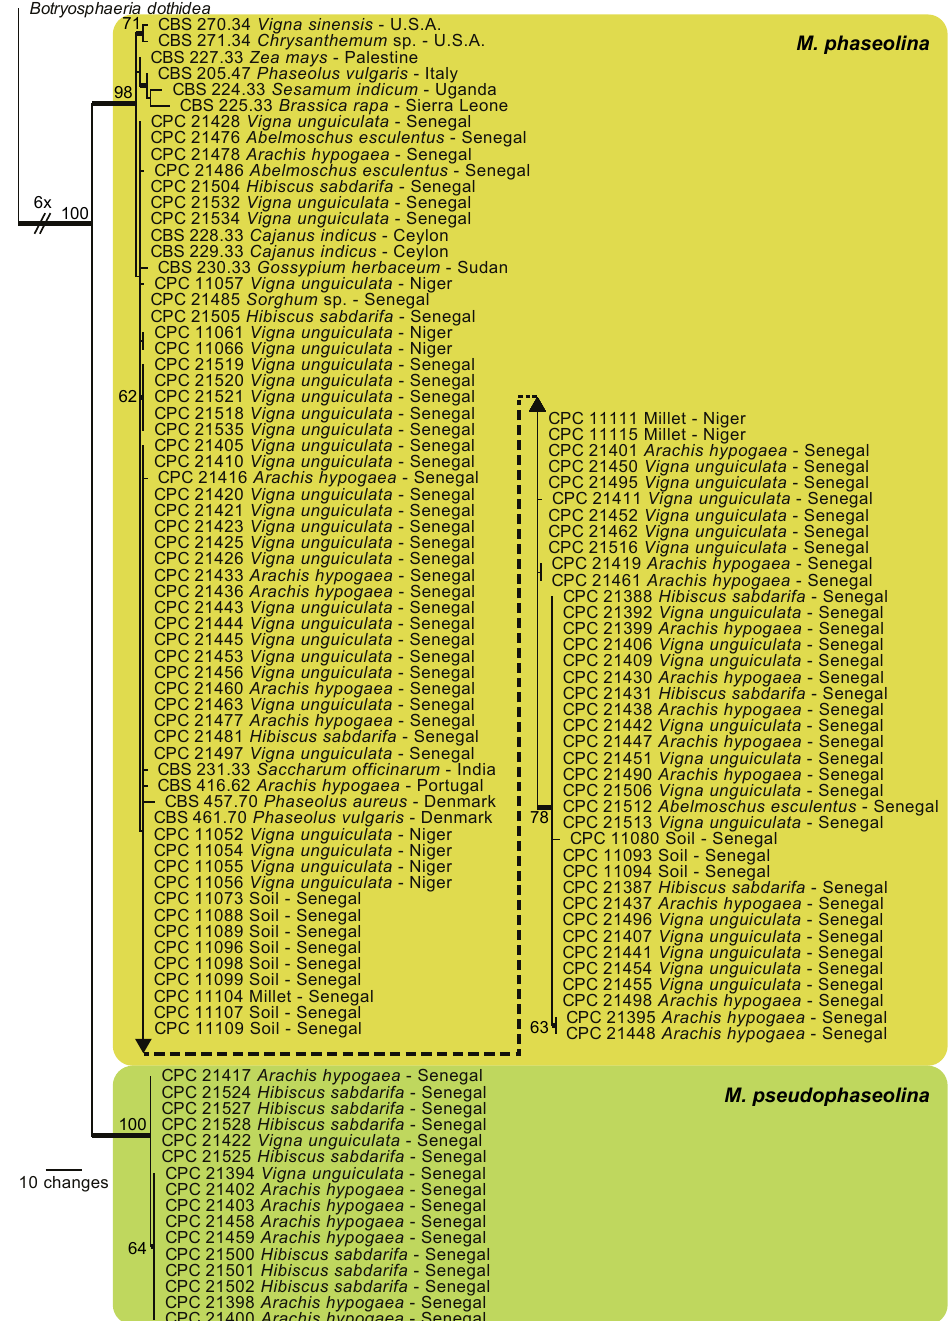
Figure 3. The first of 1,000 equally most parsimonious trees obtained from a heuristic search with 100 random taxon addi- tions of the combined three-gene (ITS, TEF-1α, ACT) sequence alignment. The scale bar shows ten changes, and bootstrap support values from 1,000 replicates are shown at the nodes. Culture collection numbers, substrate and country of origin are shown for each sequence, and coloured blocks indicate the two Macrophomina species. Branches present in the strict consensus tree are thickened and the tree was rooted to sequences of Botryosphaeria dothidea (obtained from the genome data available at: